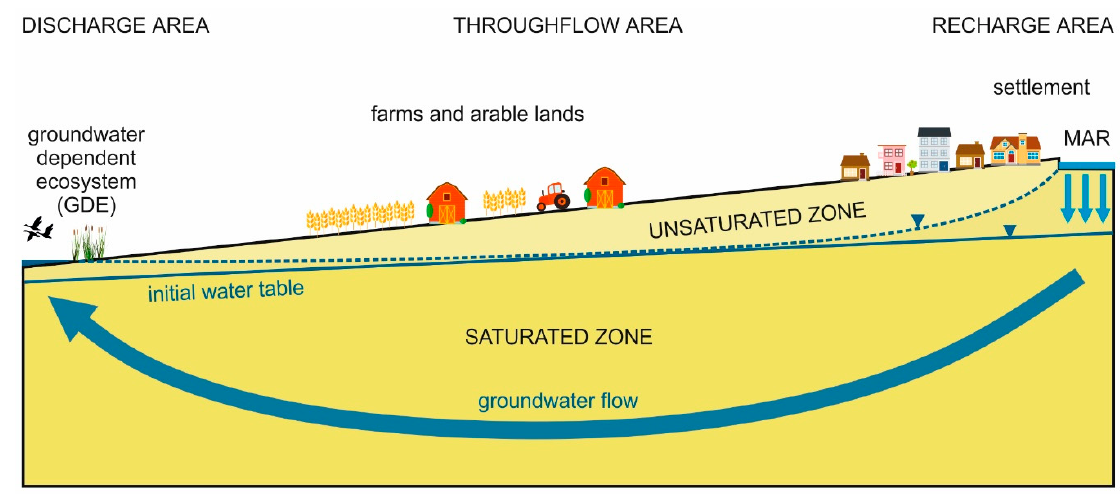
Figure 10. Conceptual approach of nature-based rehabilitation of GDEs by taking advantage of groundwater table inclination in a simple basin while using managed aquifer recharge.